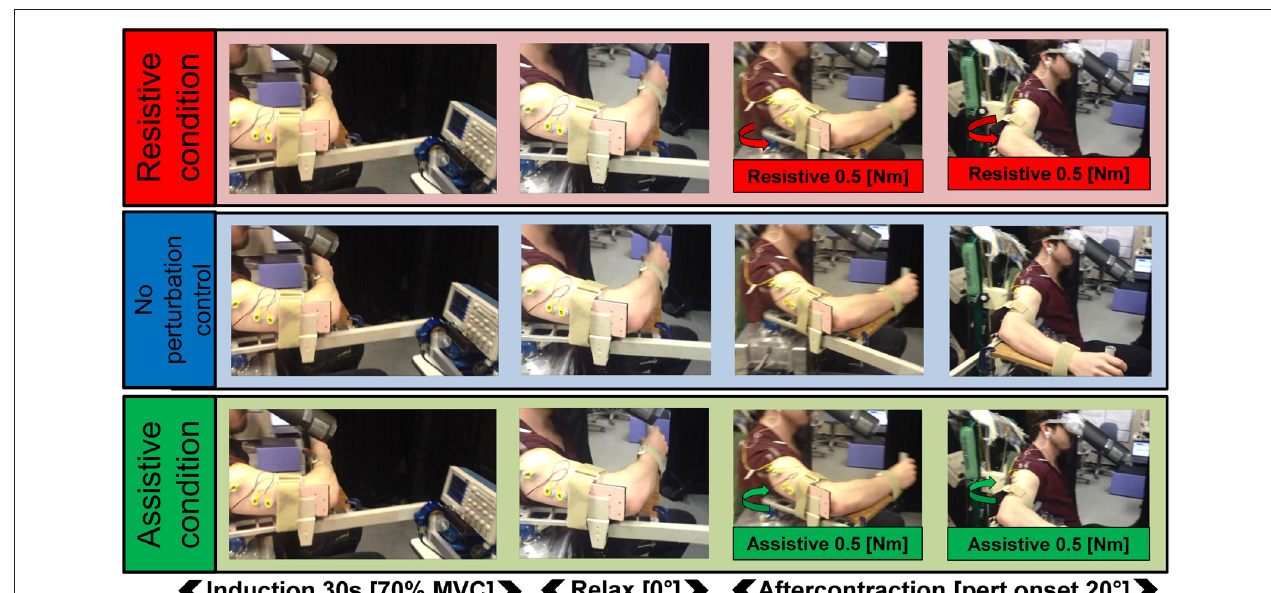
FIGURE 1 | Schematic of the task. In all three Kohnstamm perturbation conditions, participants maintained a constant isometric contraction of the right posterior deltoid for 30 s (70% MVC). They then relaxed and the aftercontraction began. In the Resistive perturbation condition, a torque was applied by the manipulandum motor in the opposite direction to the movement (0.5 Nm; 250 ms linear ramp) once the angular displacement of the arm reached 20 ◦ . In the Assistive perturbation condition, a torque was applied by the manipulandum motor in the same direction as the movement (0.5 Nm; 250 ms linear ramp) once the angular displacement of the arm reached 20 ◦ . In the No perturbation control condition, no torque was